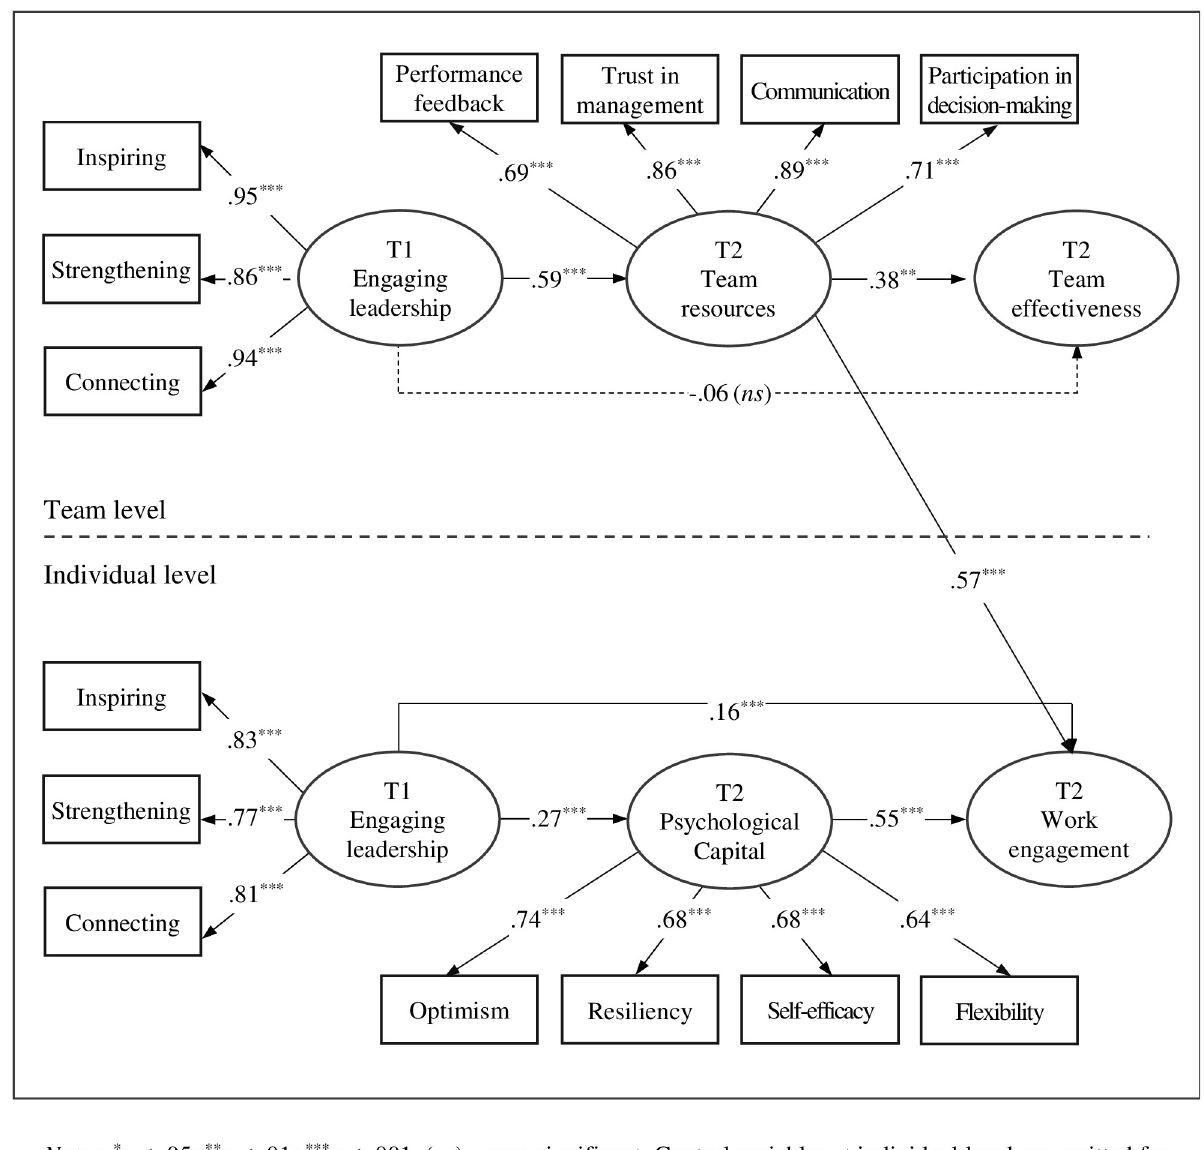
Fig 2. Standardized path coefficients of the final